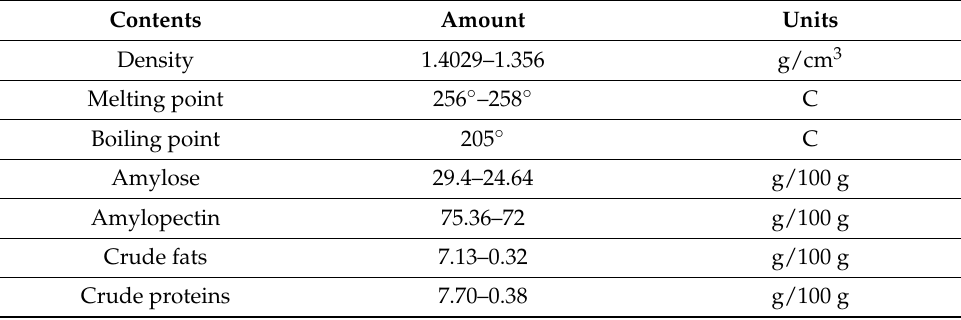
Table 1. Physical properties and chemical composition of corn starch